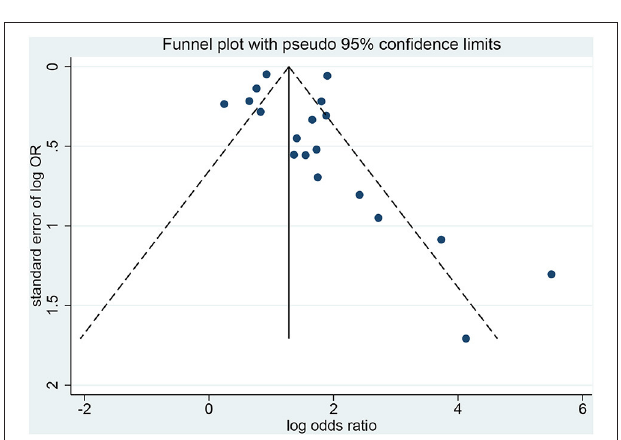
FIGURE 7 | Filled funnel plot for publication